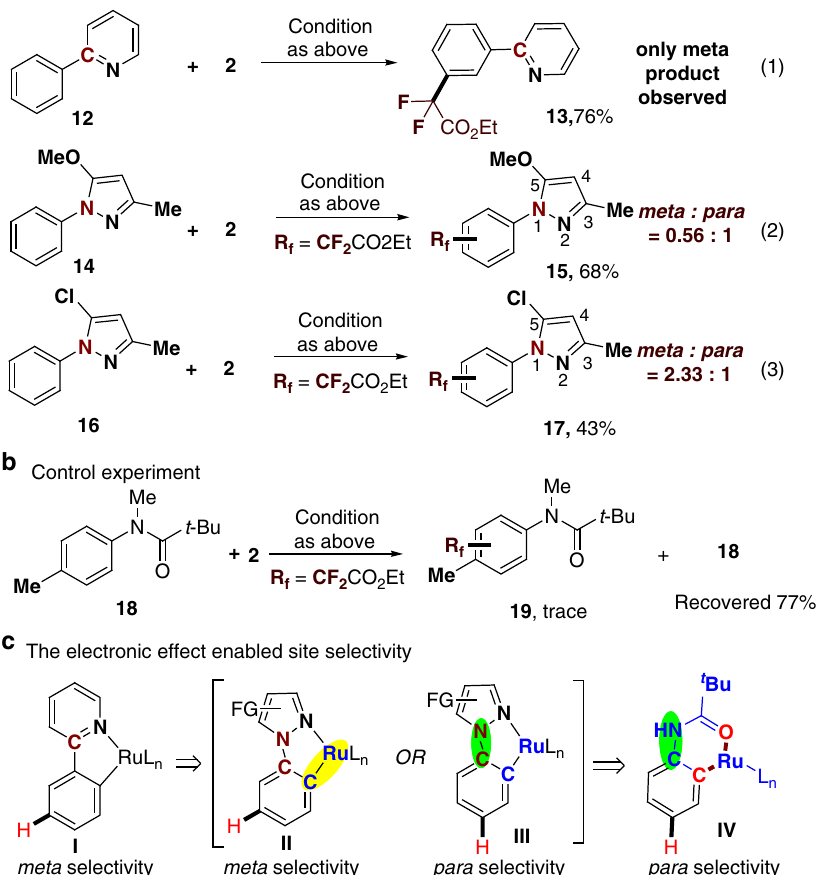
Fig. 6 Preliminary studies on site selectivity. a The electronic effect on site selectivity. b Control experiment. c The electrionic enabled site